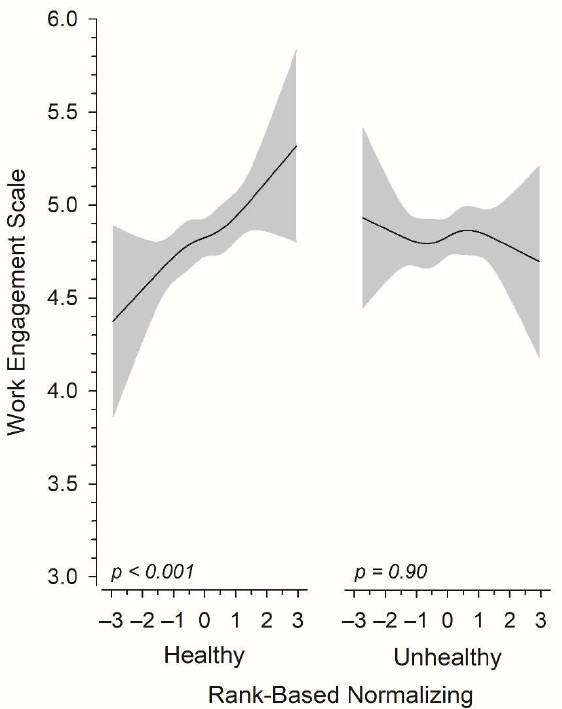
Figure 2. Relationships of total work engagement score as a function of the rank-based normalizing level of healthy and unhealthy food item consumption. The curves were derived from a 4-knot- restricted cubic splines regression models. The models were adjusted for age, education years, financial situation, physical activity hours per week, and the number of the unhealthy or healthy food items, respectively. The gray area represents the 95% confidence intervals.